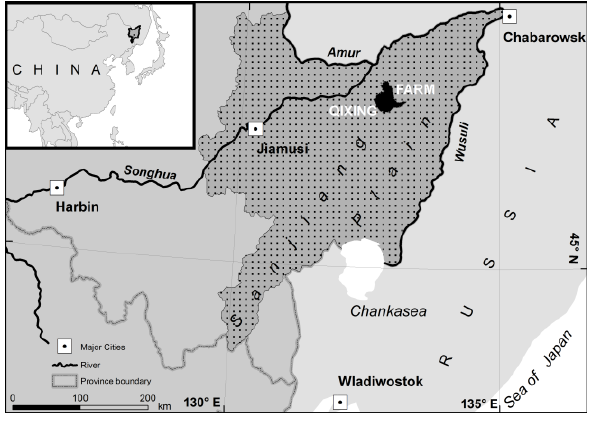
Figure 1. Location of the Qixing farm in the Sanjiang Plain